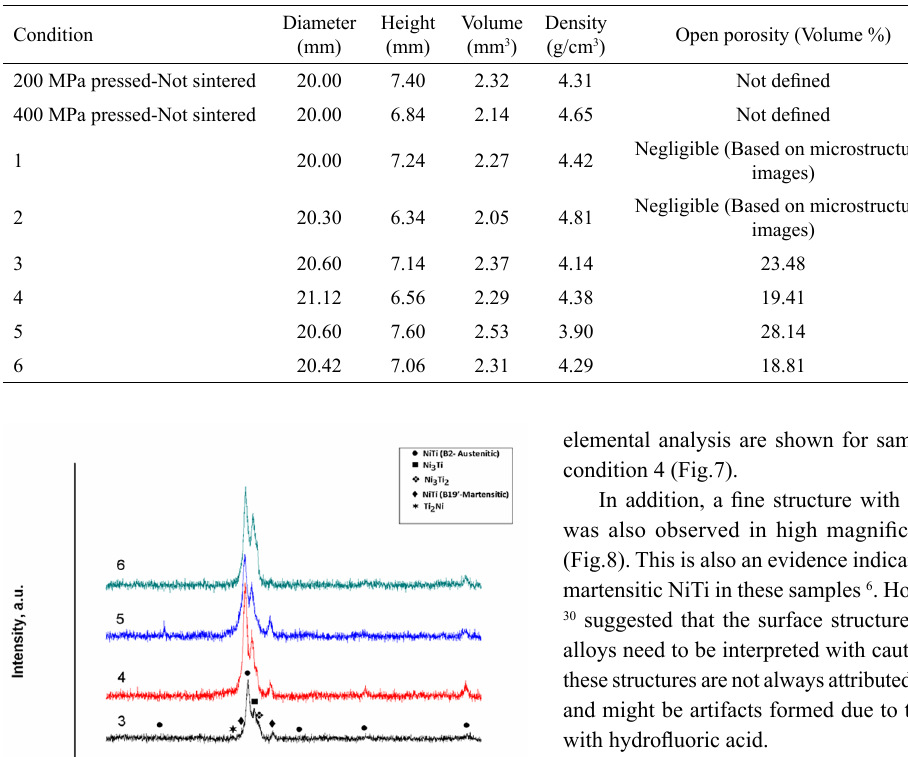
Table 2. Summary of dimensional and microstructural studies.